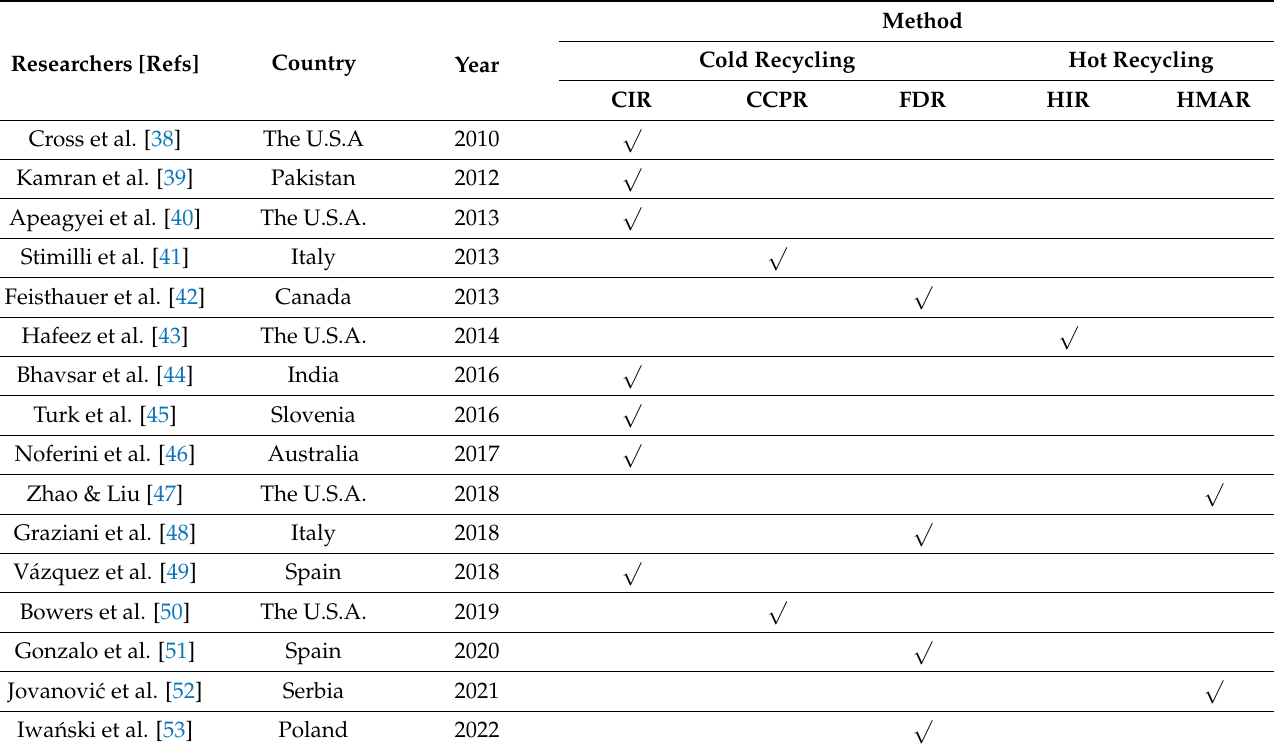
Table 1. Previous research on RAP production